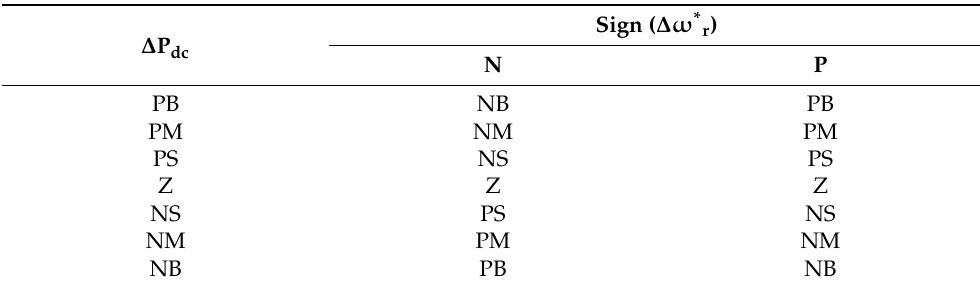
Table 1. Rule base for the fuzzy logic controller (FLC) in Figure 4. N, negative; P, positive; Z, zero; S, small; M, medium; B, big.